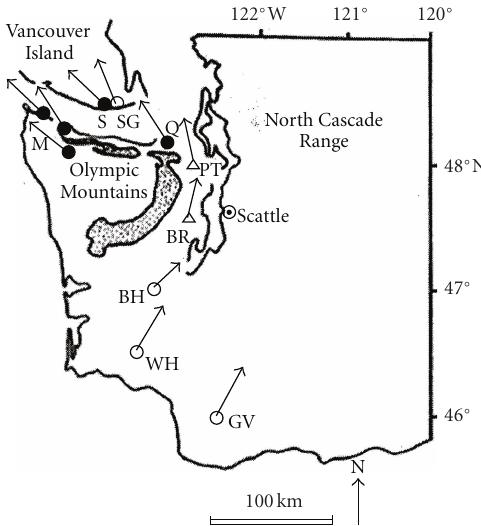
Figure 11: Sketch summary of the paleomagnetic data from lower Cenozoic units in the Olympic Peninsula. M = Makah Formation; S = Sooke Formation; SG = Sooke Gabbro; Q = Quimper Peninsula units; PT = Port Townsend basalts; BR = Bremerton basalts; BH = Black Hills; WH = Willapa Hills; GV = Goble volcanics (modified from